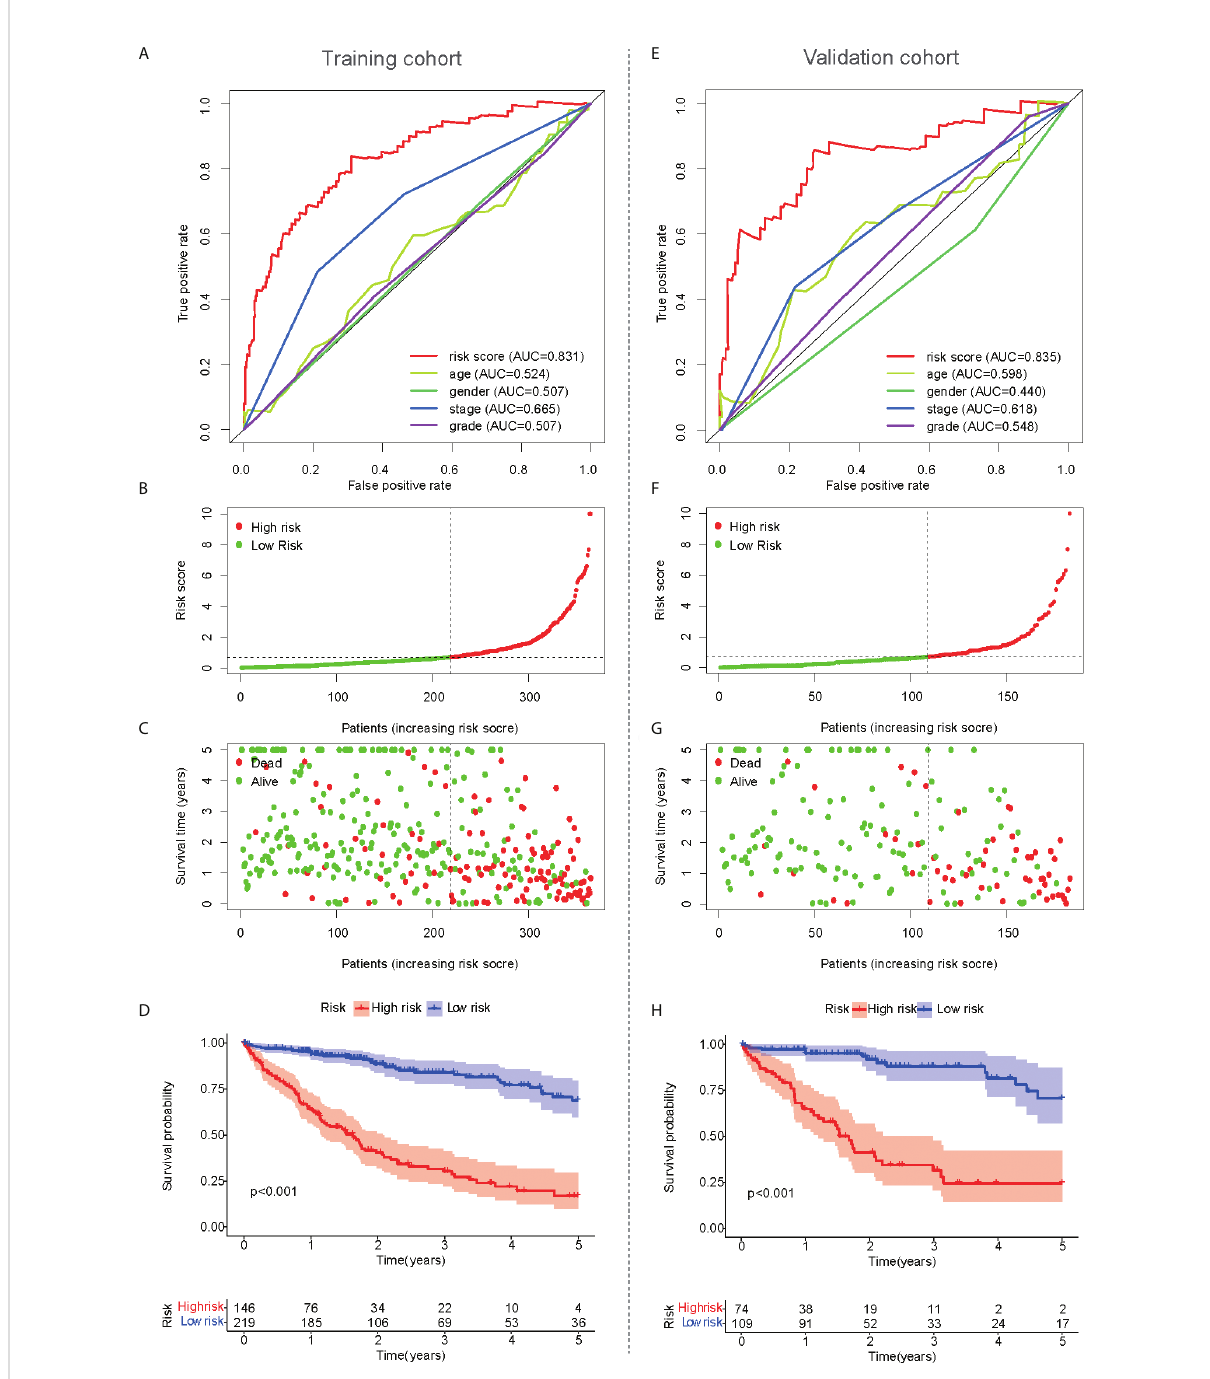
FIGURE 3 Prognostic value of mfrlncRNA signature. (A) A comparison of 1-year ROC curves with other common clinical traits indicated the advantage of the risk score in the training cohort. (B, C) Risk scores (B) and survival outcome (C) of each sample in the training cohort were shown. (D) Kaplan – Meier analysis for OS of HCC patients based on the risk strati fi cation in the training cohort. (E – H) Prognostic value of mfrlncRNA signature in the validation cohort. HCC, hepatocellular carcinoma; OS, overall